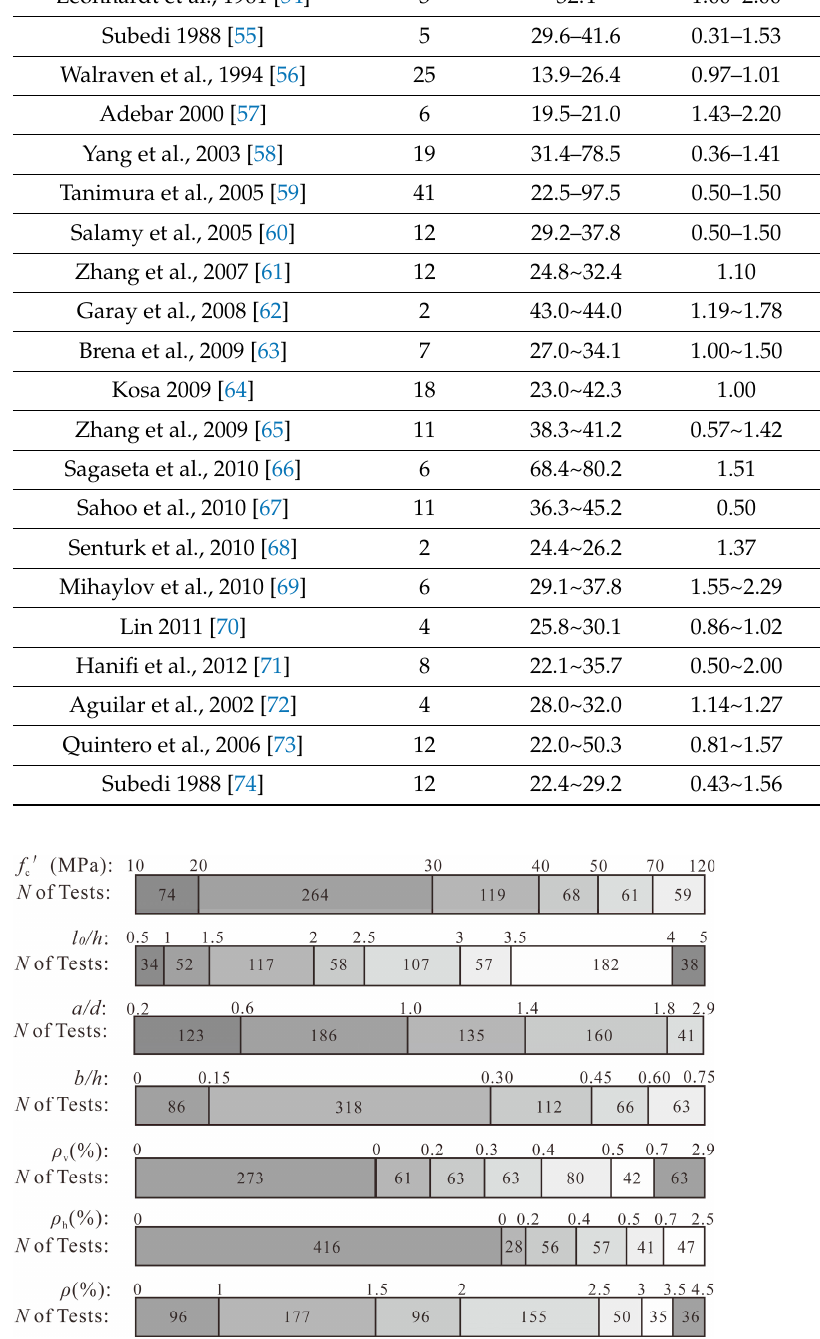
Figure 1. The distributions of main structural